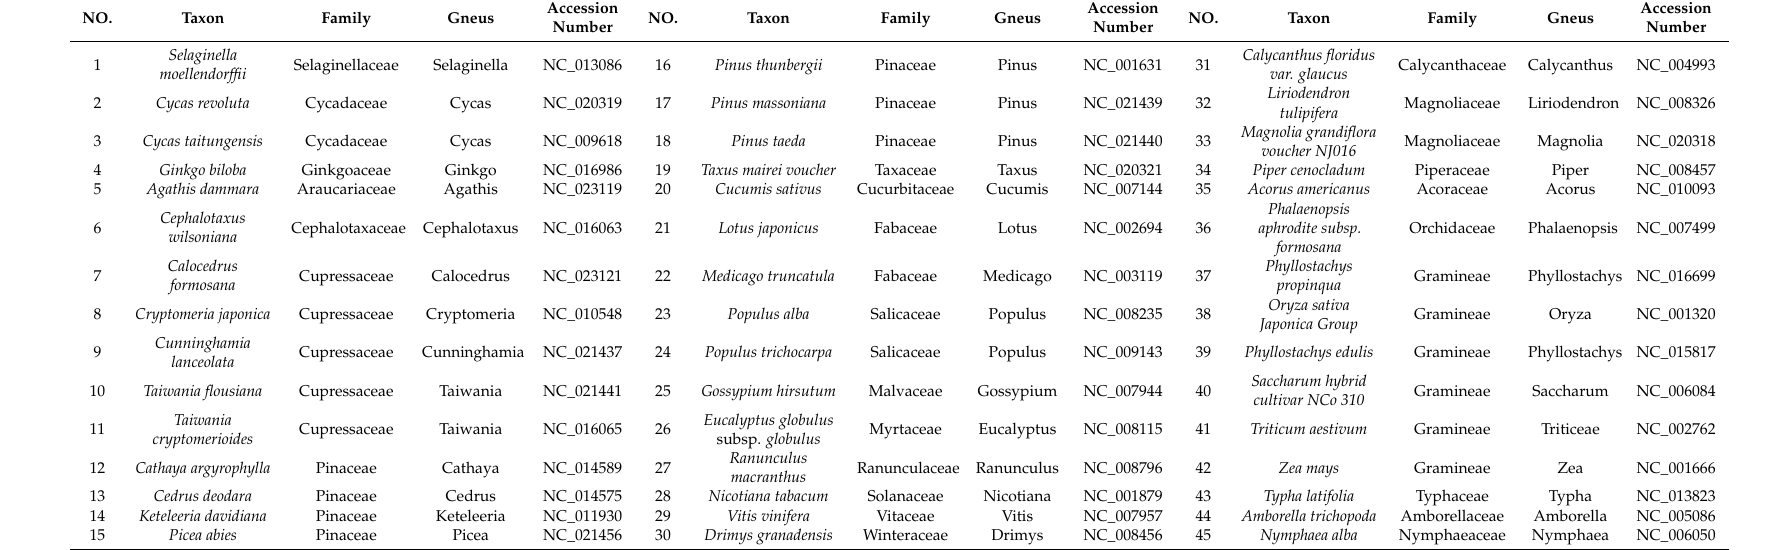
Table 2. 45 chloroplast genomes selected from Selaginella moellendorffii and almost all orders from the gymnosperms and angiosperms in order to minimize missing data and balance taxon